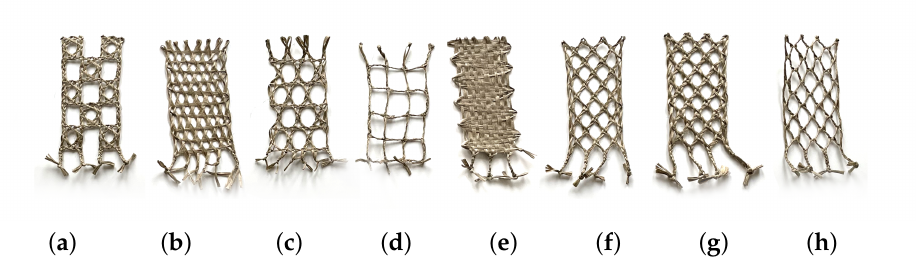
Figure 5. Lace patterns before stitching. From left to right: ( a ) A la Vierge, ( b ) Grille, ( c ) Quadrille Croise, ( d ) Quadrille Simple, ( e ) Toile, ( f ) Torchon, ( g ) Double Torchon, ( h ) Tulle.